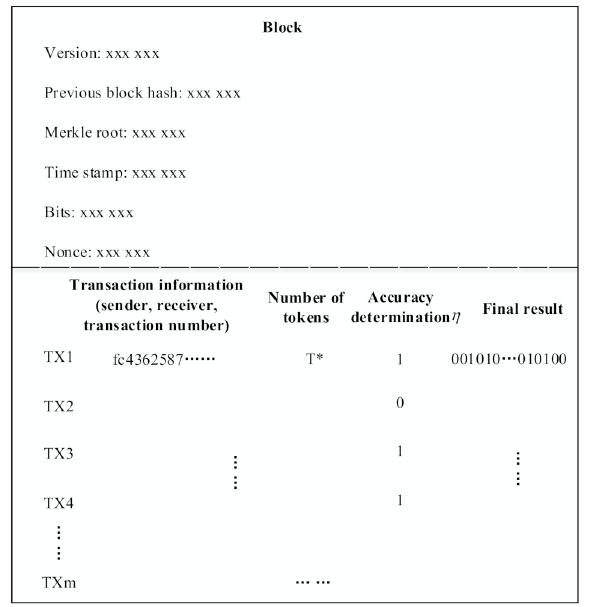
Figure 7. Block of transaction returned by fusion decision